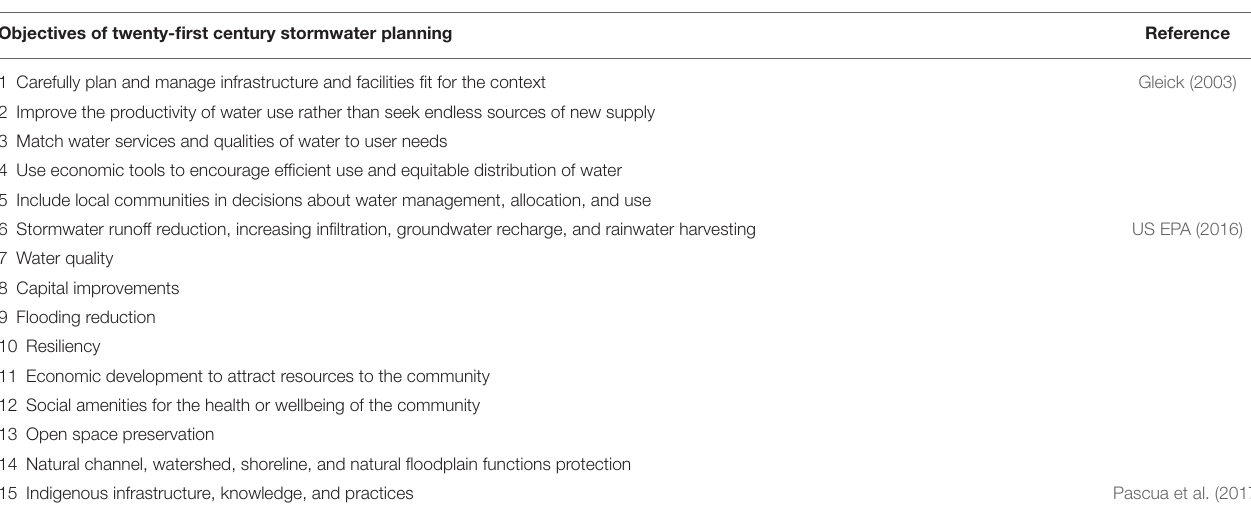
TABLE 1 | Fifteen objectives for stormwater planning and